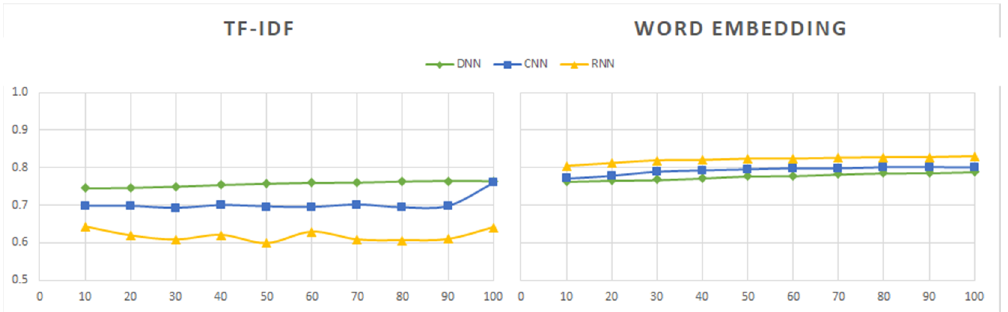
Figure 12. Precision values of DNN, CNN, and RNN models with TF-IDF and word embedding for different numbers of tweets (percentage of the dataset).